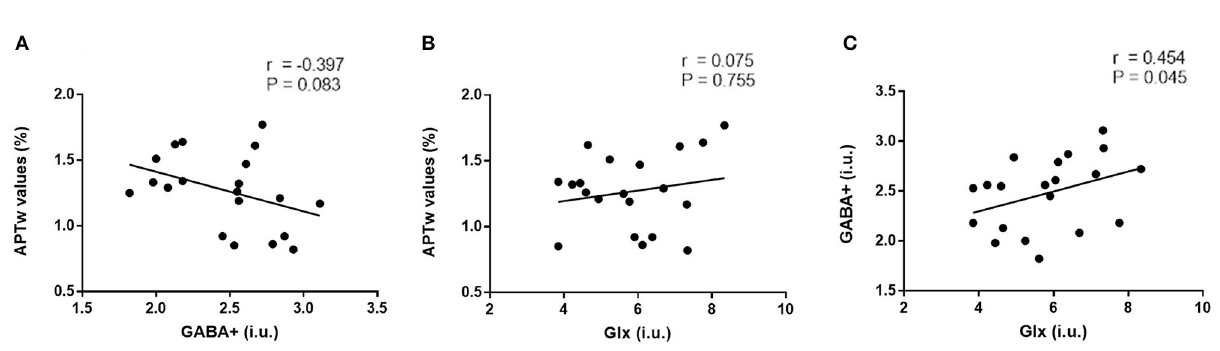
FIGURE5 Correlation analysis of right hippocampus metabolites. No significant correlation was found between APTw values and GABA + levels of the right hippocampus [ r = − 0.39, P = 0.083, (A) ]; similar results were found between APTw values and Glx levels [ r = 0.074, P = 0.755, (B) ]. There is a moderate positive correlation between Glx and GABA + levels [ r = 0.454, P = 0.045, (C) ].